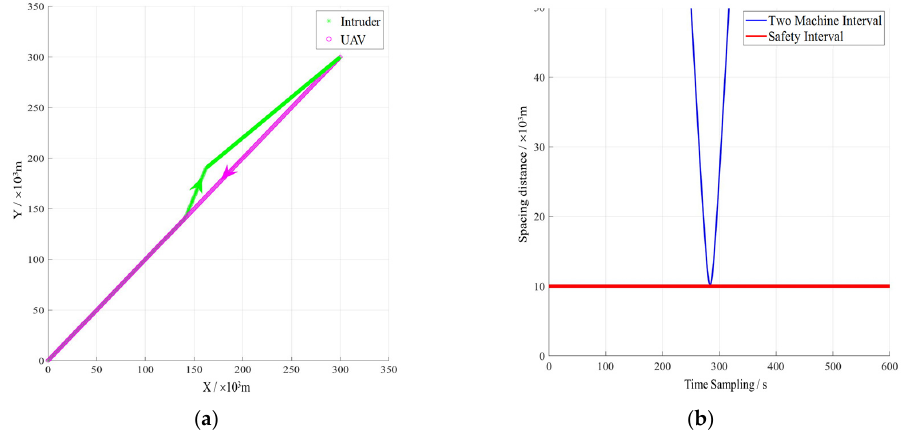
Figure 10. Voyage deliverance scenario analysis: ( a ) navigate to the relief scene; ( b ) two-machine interval.